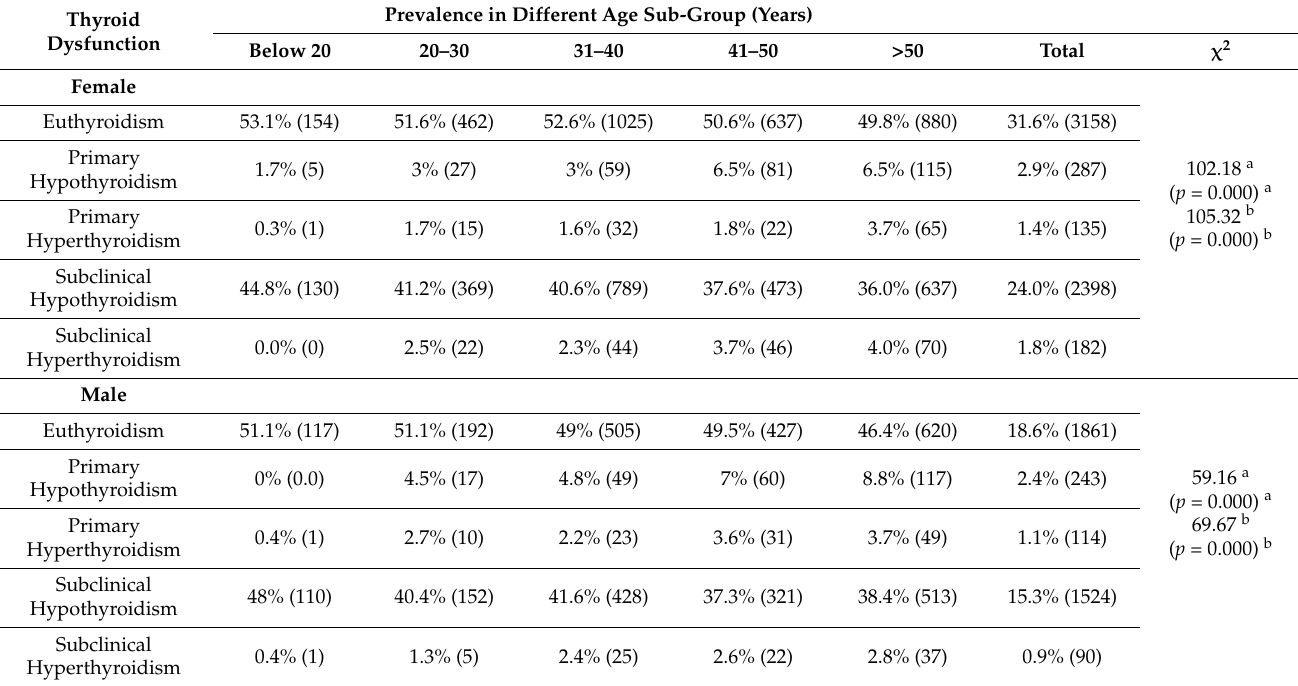
Table 3. Prevalence of thyroid dysfunction on different genders stratified by age subgroup. Thyroid